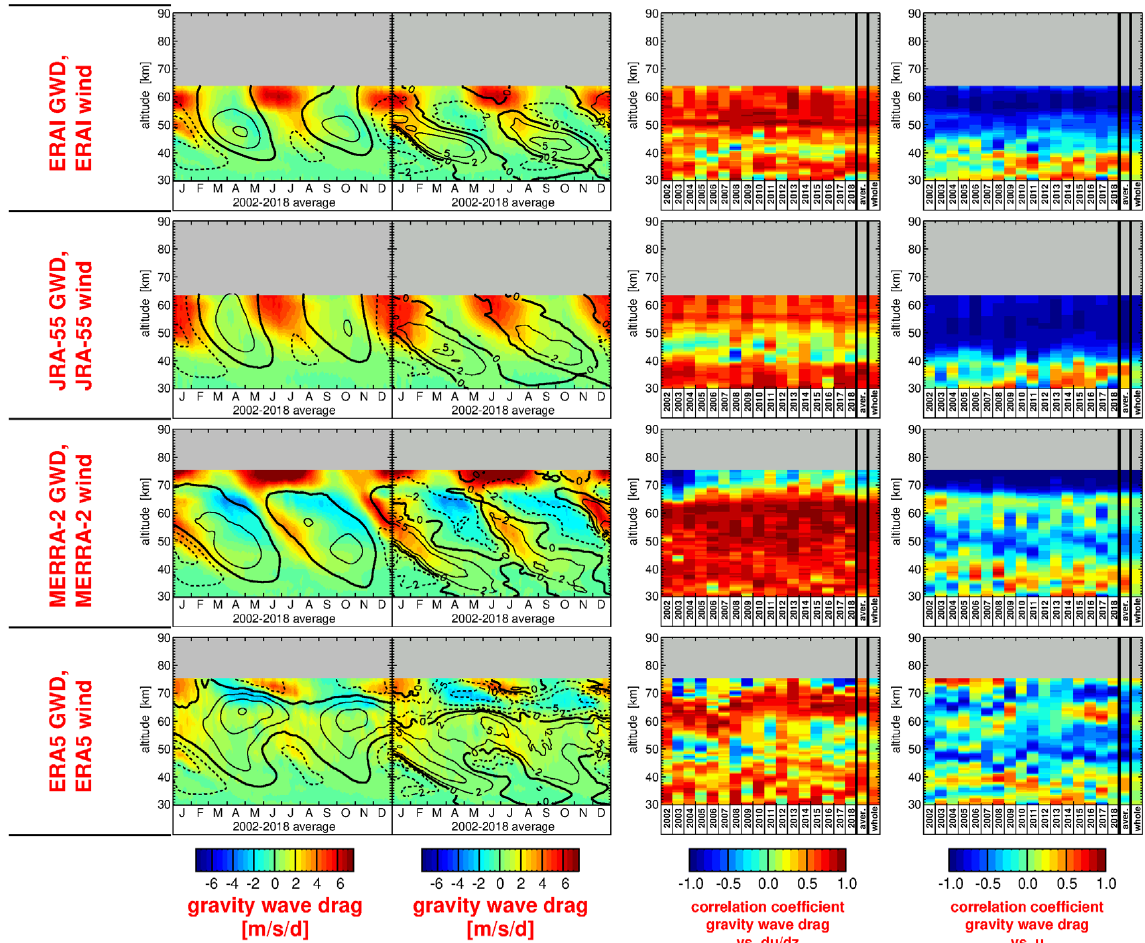
Figure 9. Left column: gravity wave drag (in ms − 1 d − 1 ) derived from the four reanalyses considered in this study, averaged over the latitude band 10 ◦ S–10 ◦ N and the years 2002–2018, overlaid with contour lines of the corresponding zonal winds averaged over the same latitudes and time period. Second column: same as left column but contour lines are the vertical gradient of the zonal wind. Third column: temporal correlations between reanalysis gravity wave drag and zonal wind vertical gradients, separately for each year, for the averages over the different years, and for the time series as a whole. Right column: temporal correlations between reanalysis gravity wave drag and zonal wind, separately for each year, for the averages over the different years, and for the time series as a whole. The different rows are (from top to bottom) for (1) ERA-Interim, (2) JRA-55, (3) MERRA-2, and (4) ERA-5. For zonal winds, contour line increment is 20ms − 1 . The zero wind line is highlighted in bold solid contour lines, and westward (eastward) winds are indicated by dashed (solid) contour